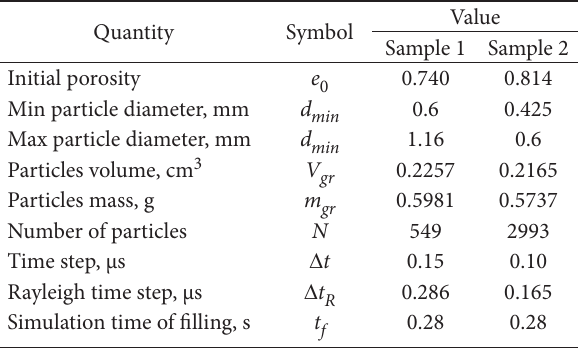
Table 2. Data of the generated samples